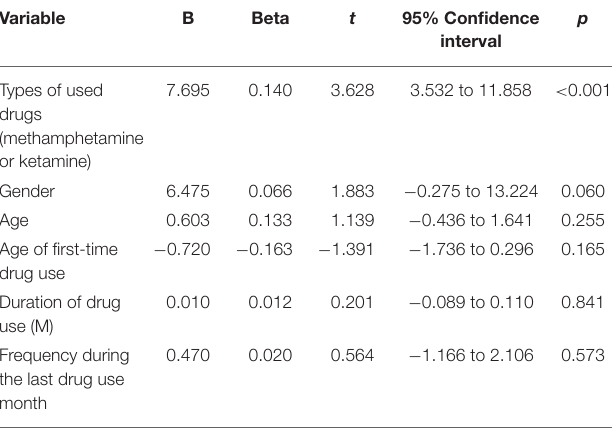
TABLE 3 | Positive, negative, and general symptoms assessed by PANSS between two groups.